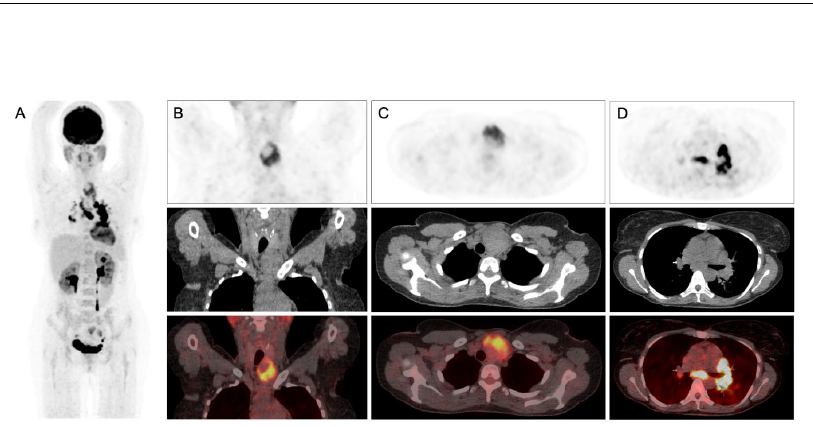
Figure 1. 18 F-FDG PET/CT of the patient: ( A ) Maximum Intensity Projection image, ( B ) coronal images, ( B ) transaxial images of the lower neck ( C , D ) and transaxial images of the thorax (PET, upper; CT, middle; fused PET/CT, lower). A 41-year-old female was initially evaluated for posterior neck pain irradiating to the shoulders for several months. She was known to have a heterozygote checkpoint kinase 2 (CHEK2) mutation and had a medical history of high blood pressure and Bell’s palsy in 2017. The family history revealed that her mother was diagnosed with breast cancer at a young age. Computed tomography (CT) of the cervical spine revealed an incidental 56 mm thyroid nodule with a tracheal shift. Thyroid function tests were normal. Fine-needle aspiration cytology showed “Follicular Lesions of Undetermined Significance” (FLUS), also referred to as “Atypia of Undeter- mined Significance” (AUS) or classified as category III according to the Bethesda system. The patient was set to undergo a thyroid lobectomy, but surgery was delayed due to the COVID-19 pandemic. Three months after the initial presentation, the patient presented with mild shortness of breath, dry cough, and fever for three weeks prior to the visit, but she no longer complained of neck pain. Phys- ical examination showed a palpable nodule of the left thyroid lobe. Laboratory investigations showed a white blood cell count of 4000/mm 3 (normal range 4000–11,000) and a C-reactive protein (CRP) level of 1.4 mg/L (normal range < 5.0), and the serum angiotensin-converting enzyme level was elevated at 125 U/L (normal range 20–70). Other biological parameters were unremarkable. Pol- ymerase-chain-reaction (PCR) assay and serologic tests showed no evidence of active infection with SARS-CoV-2, influenza A and B. A chest X-ray revealed mild enlargement in the bilateral hilar re- gions. Chest CT showed bilateral mediastinal and bilateral hilar enlarged lymph nodes and several micronodules in the middle lobe and the left lower lobe. Tuberculin skin test was negative, and the pulmonary function tests were normal. 18 F-FDG PET/CT shows a heterogeneously increased FDG uptake in the thyroid nodule (SUVmax 9.9) and an intense FDG uptake in mediastinal and bilateral hilar lymph nodes (SUVmax 23.6). A mild FDG uptake in the lower fields of both lungs was also observed. Endobronchial Ultrasound-guided Transbronchial needle aspiration (EBUS-TBNA) of a left hilar lymph node showed epithelioid non-necrotizing granulomas. Sarcoidosis was diagnosed based on the FDG PET/CT findings and the EBUS-TBNA results. Oral methylprednisolone was ini- tiated, soon improving the symptoms. Thyroid lobectomy was performed one month later. Histo- pathological results of the thyroid specimen also revealed multiple non-necrotizing epithelioid granulomas and no signs of malignancy. These findings along with the thoracic findings on 18 F-FDG PET/CT suggested sarcoidosis involvement of the thyroid gland. Sarcoidosis is a multisystem gran- ulomatous disease that mainly involves the lungs, thoracic lymph nodes, and the skin. Thyroid gland involvement is rare, accounting for 1 to 4% of patients with systemic sarcoidosis [1,2]. Thyroid sarcoidosis usually presents as diffuse goiter, but multinodular goiter and solitary nodule are also reported [3–5]. Symptoms include oppressive thyroid pain, dyspnea and dysphagia [3]. Laboratory results generally show normal thyroid function or hypothyroidism [6]. The final diagnosis of thy- roid sarcoidosis is often made with FNAC, after thyroidectomy or autopsy [1,3]. Coexisting thyroid disorders such as Hashimoto’s disease, Grave’s disease and thyroid carcinomas are common [4]. 18 F-FDG PET/CT has an established role in the evaluation of various malignancies and inflammatory disorders due to an increased glucose transporter expression and upregulation of hexokinase en- zymes in neoplastic and inflammatory cells [7]. The clinical use of 18 F-FDG PET/CT in the diagnosis and management of sarcoidosis is increasing. FDG uptake in sarcoid lesions has been shown to be due to the high glycolytic activity of activated macrophages and lymphocytes [7]. Typical thoracic